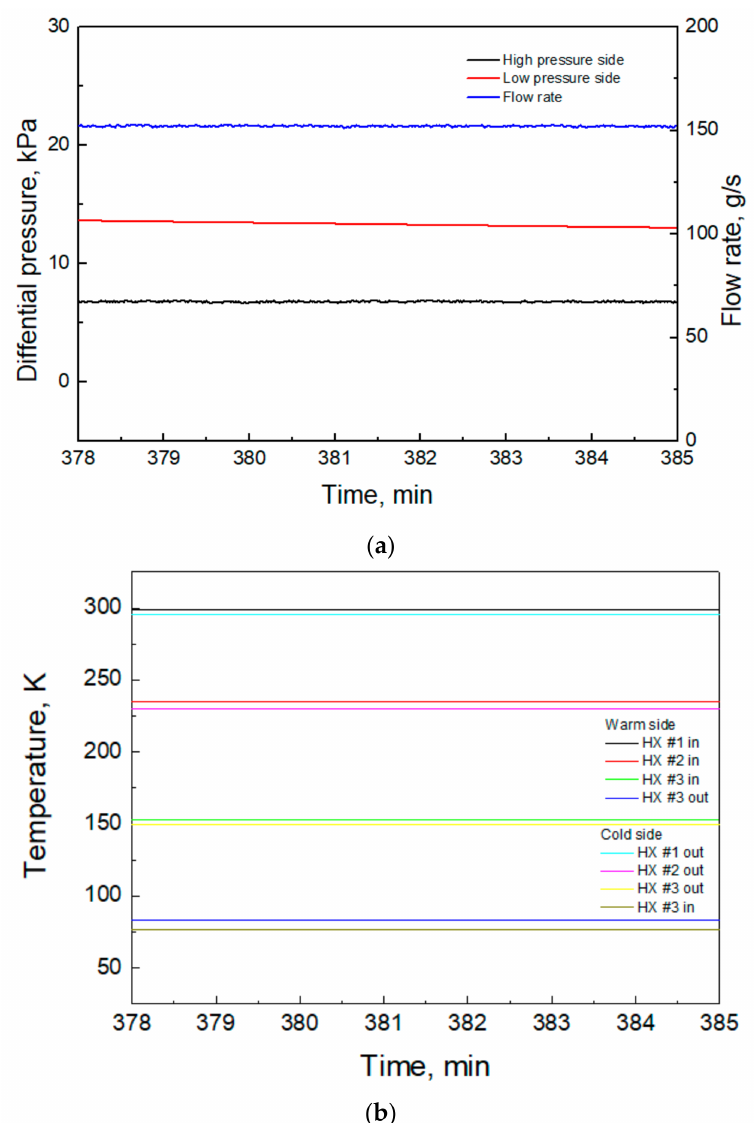
Figure 6. Measurement results for the heat exchanger: ( a ) mass flow rate and pressure drop of the high- and low-pressure sides and ( b ) inlet and outlet temperatures of each heat exchanger